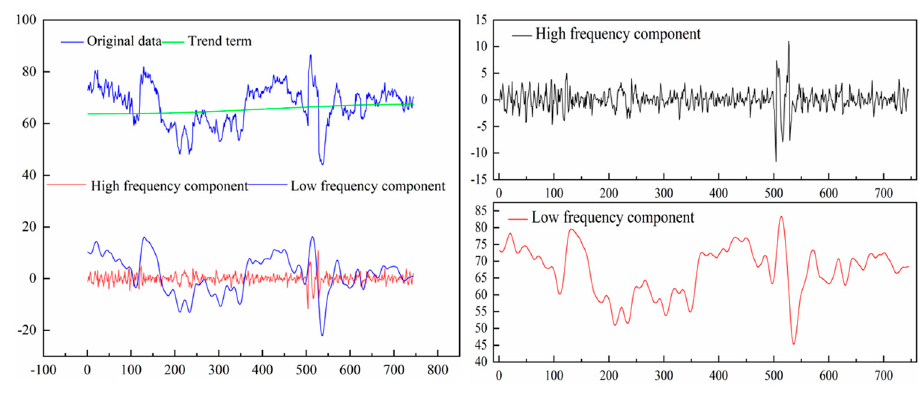
Figure 8. The permutation entropy of each component.